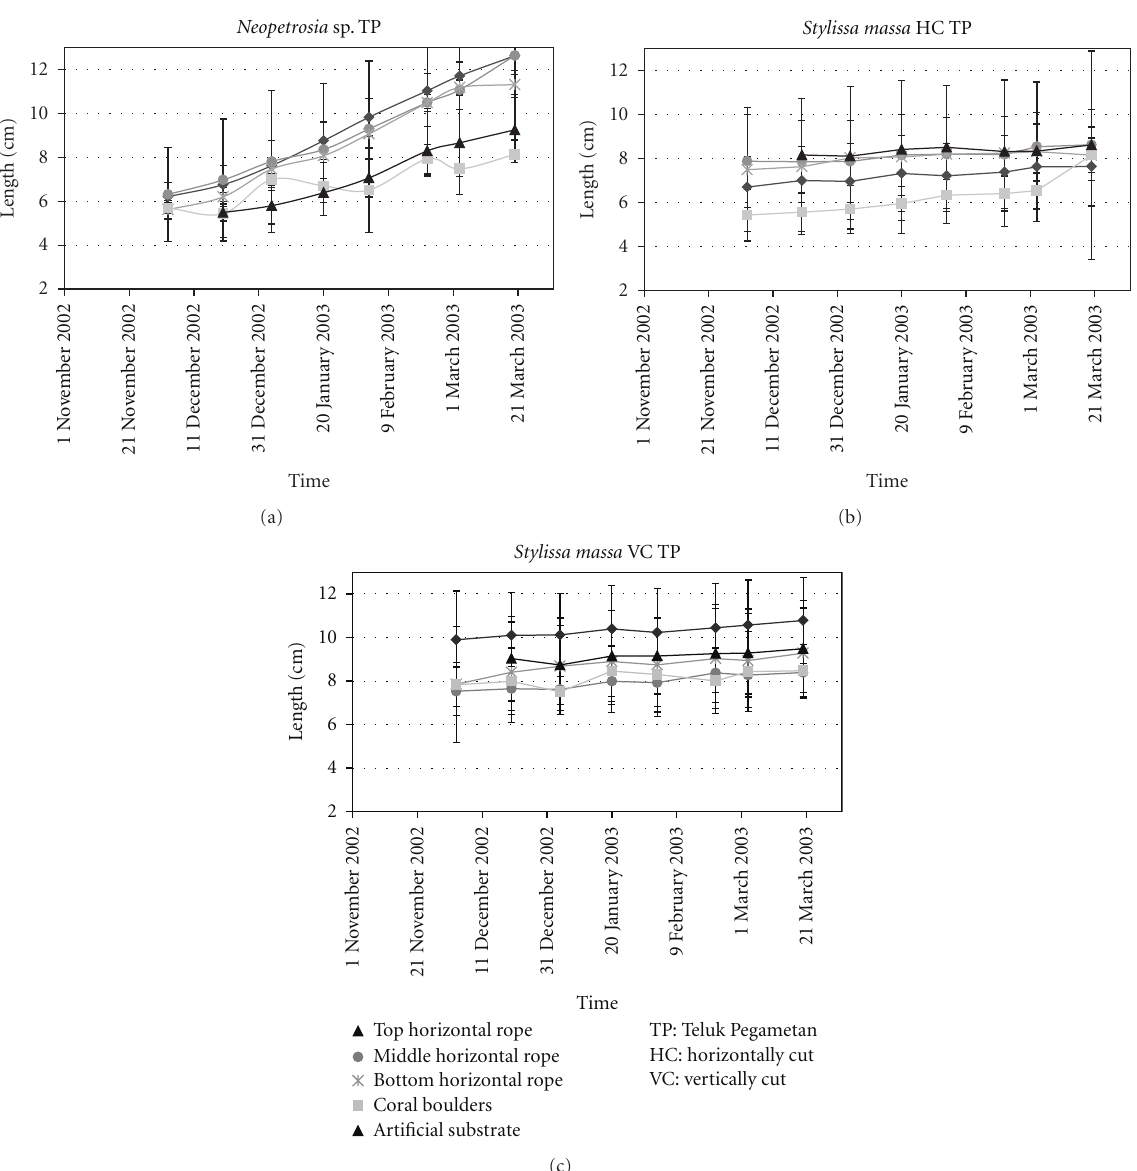
Figure 6: Fragments mean length at the field sites for di ff erent attachment methods and di ff erent